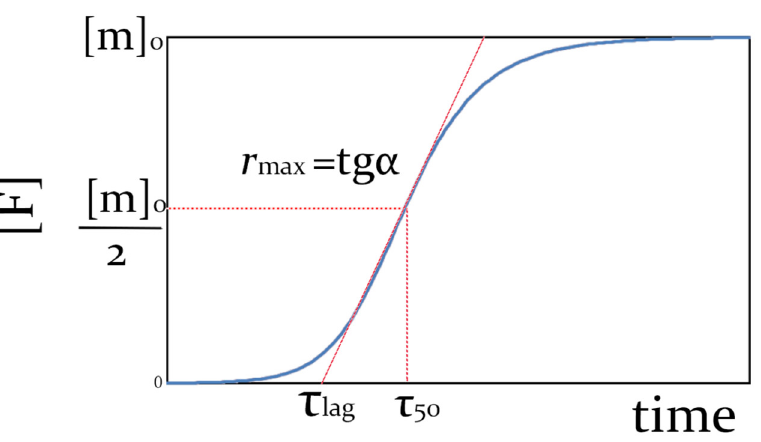
Figure 1. Typical time dependence of protein concentration converted into fibrils ([F]) and the quantities used to describe this curve.